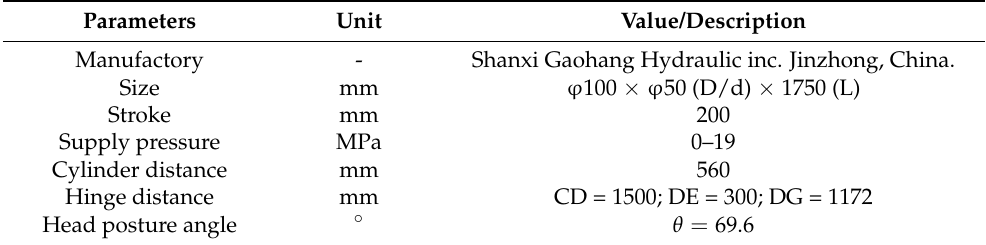
Figure 4. Floating function: ( a ) working principle and ( b ) working flow chart. Table 6. Hydraulic cylinder